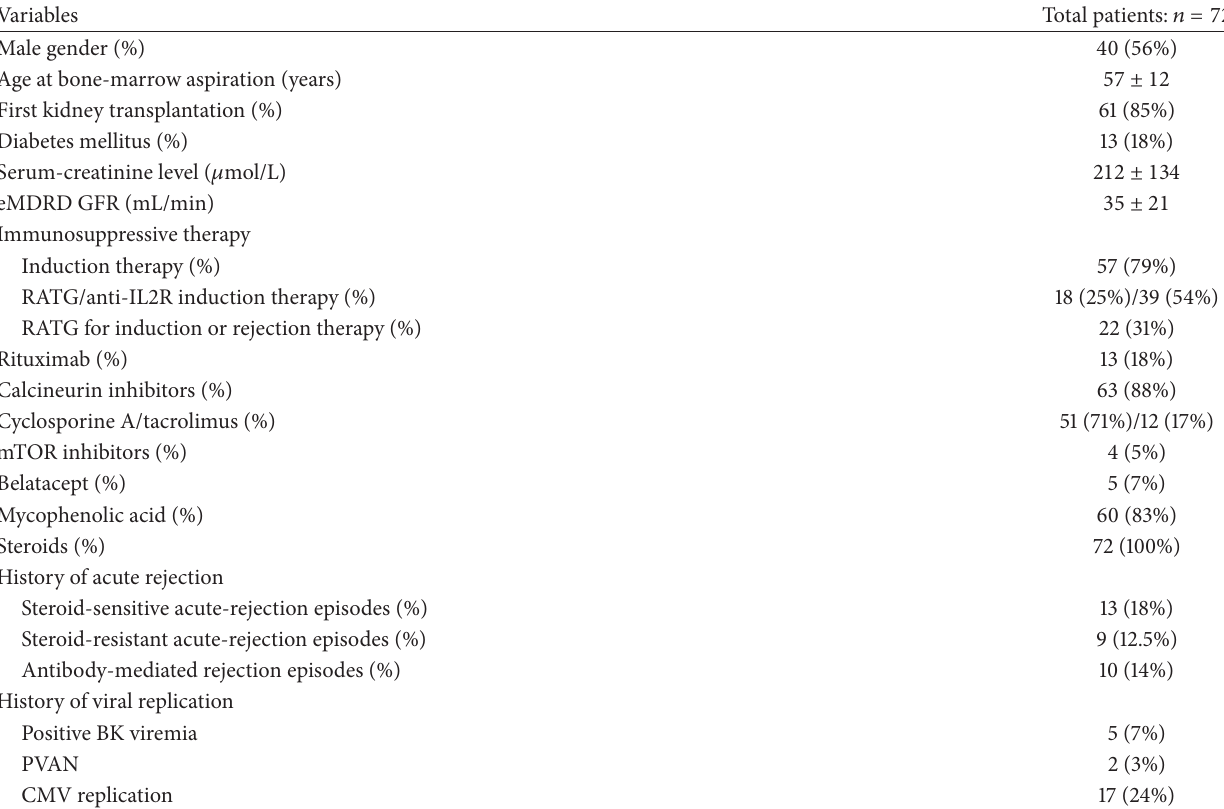
Table 1: Patients’ characteristics and bone-marrow aspirates.